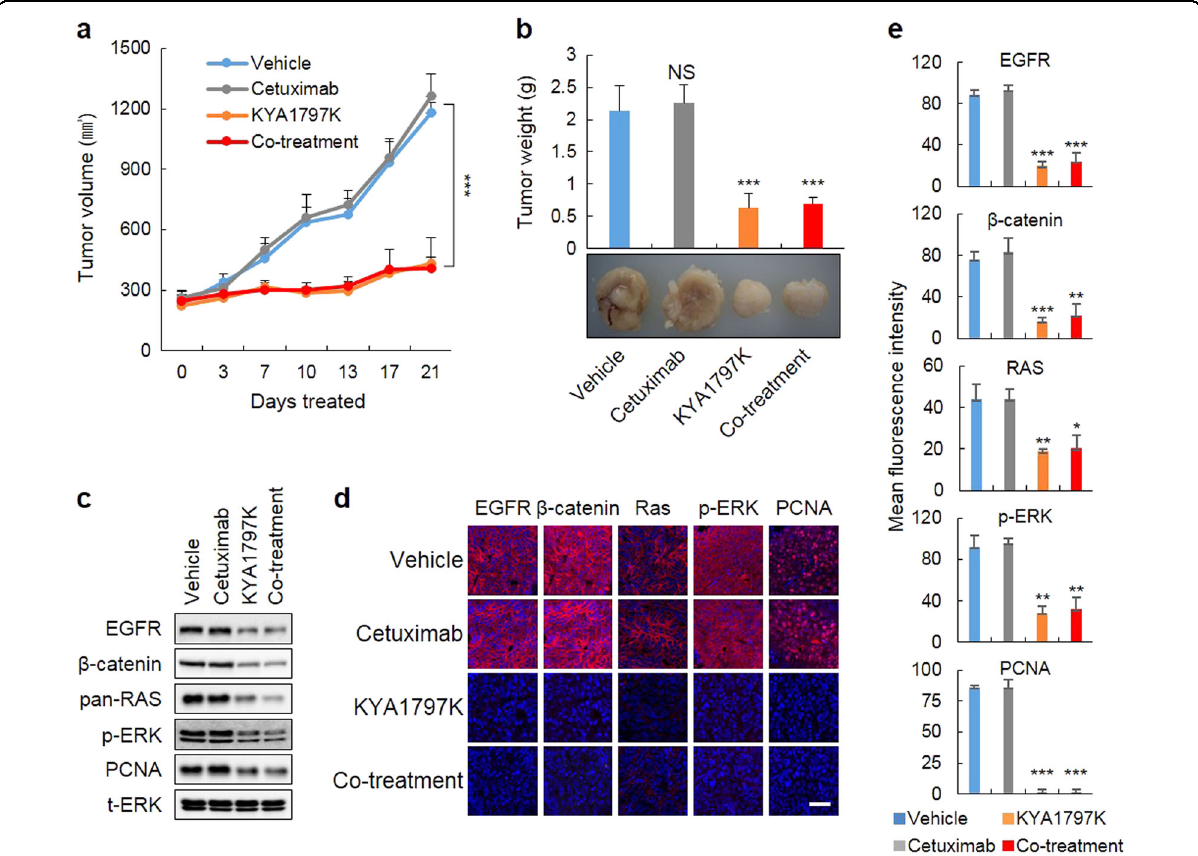
Fig. 4 KYA1797K overcomes the resistance to cetuximab attributed to KRAS mutations on tumor xenograft growth. a D-MT cells were subcutaneously injected into nude mice with the subsequent intraperitoneal (i.p.) injection of vehicle, 20 mg/kg KYA1797K, 1 mg/mouse cetuximab, or a combination of KYA1797K (20 mg/kg) and cetuximab (1 mg/mouse) for 21 days. The tumor volumes were measured every 3 days. b The measurement of tumor weights ( b , upper panel) and the visualization of tumor images ( b , lower panel) were performed at the time of killing. c WCLs prepared from the tumor tissues were subjected to IB analysis. d IHC analysis of the tissue sections incubated with the indicated antibodies and then counterstained with 4 ′ ,6-diamidino-2-phenylindole (DAPI). Scale bar, 50 µm. e The levels of the proteins were measured by the mean fl uorescence intensity. The data are presented as the mean ± SD ( n = 5). Two-sided Student ’ s t- test, * P <0.05, ** P <0.005, and *** P <0.001. NS not signi fi